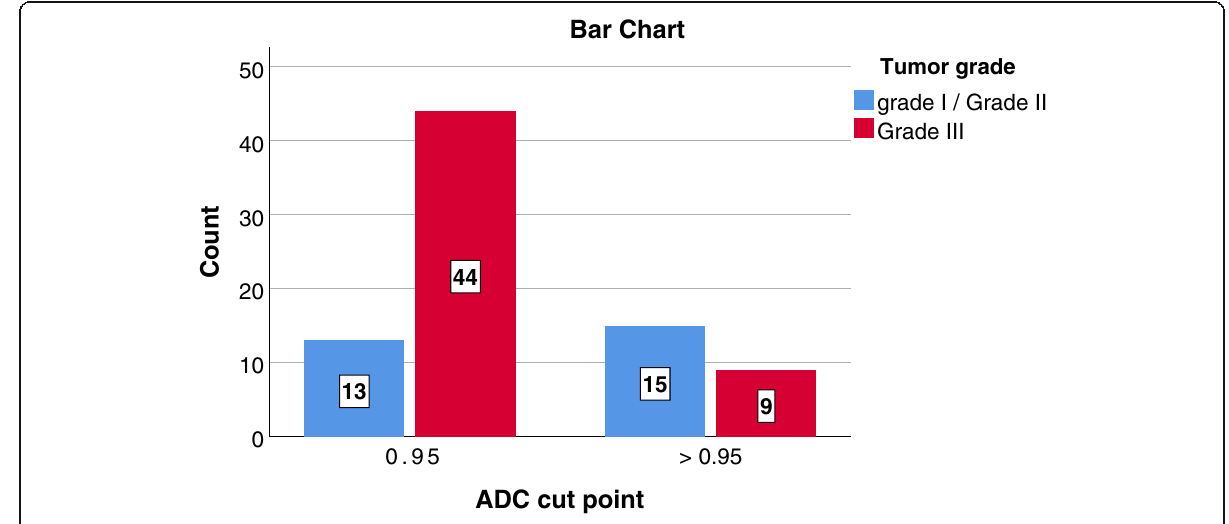
Fig. 9 Bar chart that shows ADC cut off value between GIII and grades I/II lesions